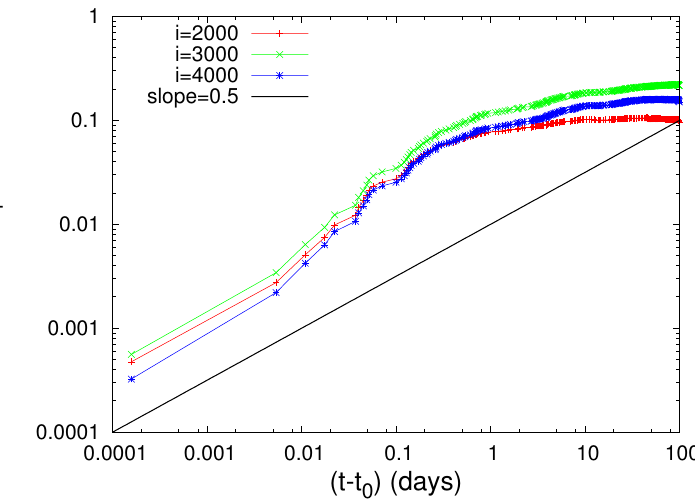
Figure 17. The same as Figure 16, but for the M 7.1 EQ on 2 November 1989 with an epicenter at 39.86 ◦ N 143.05 ◦ E. The t 0 value is 0.022 days measured from the M 7.1 EQ occurrence and c = 0.5. Taken from Ref. [87].